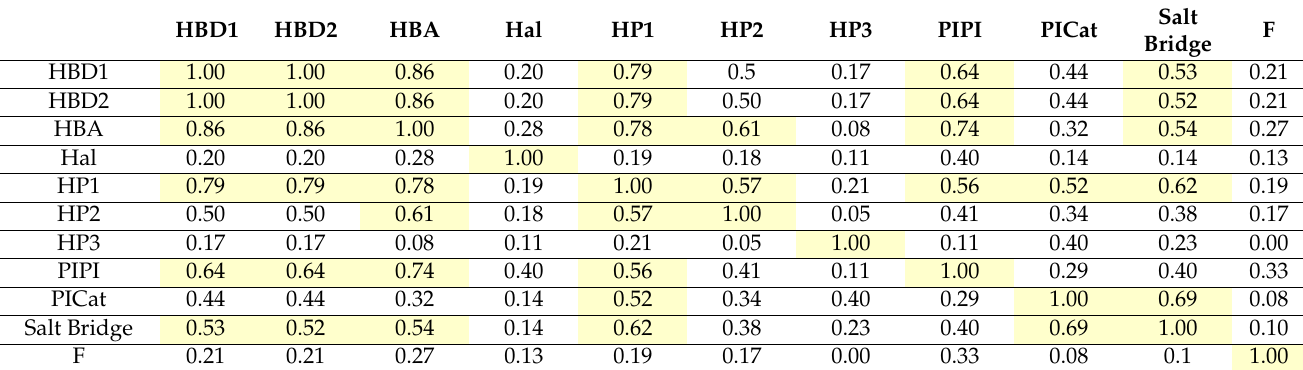
Table 2. Correlation (r) between the chemical